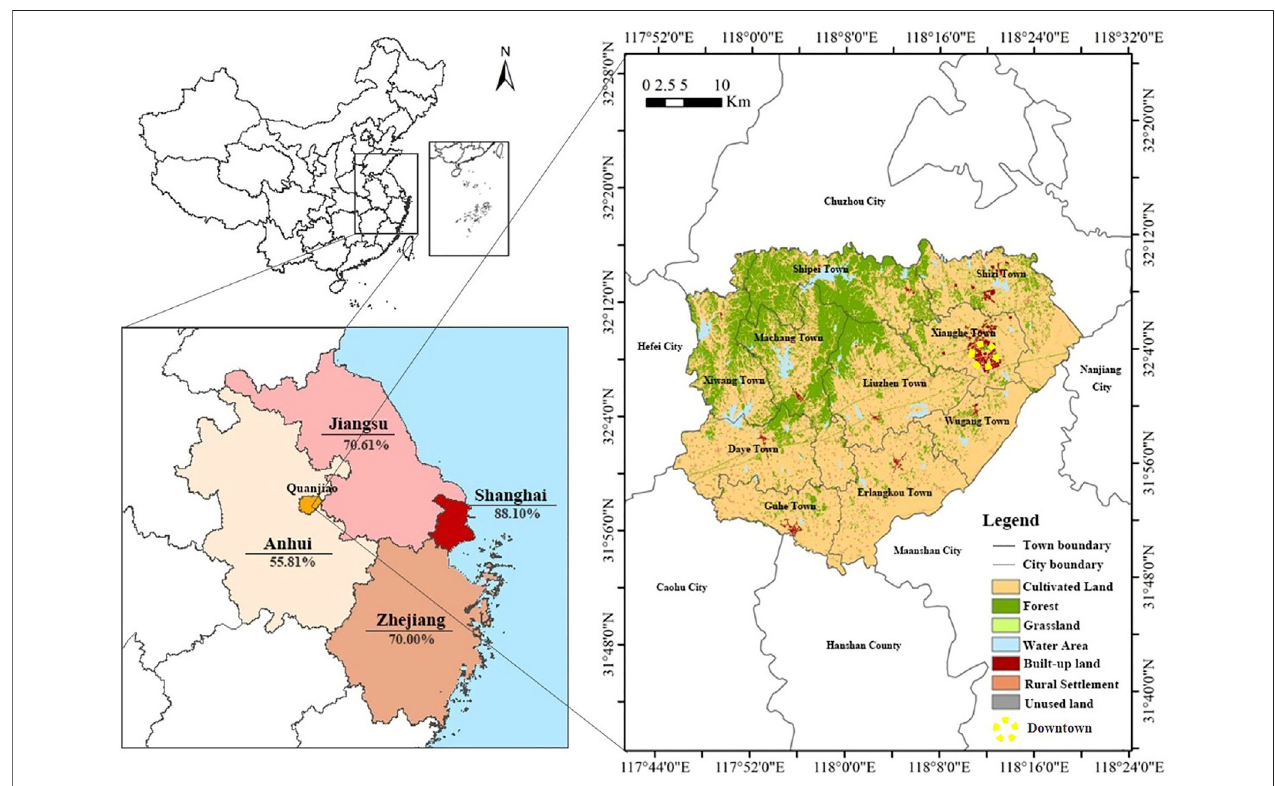
FIGURE 1 | Location of the study area. (The numbers below province names refer to the urbanization rate of each province in 2019.)